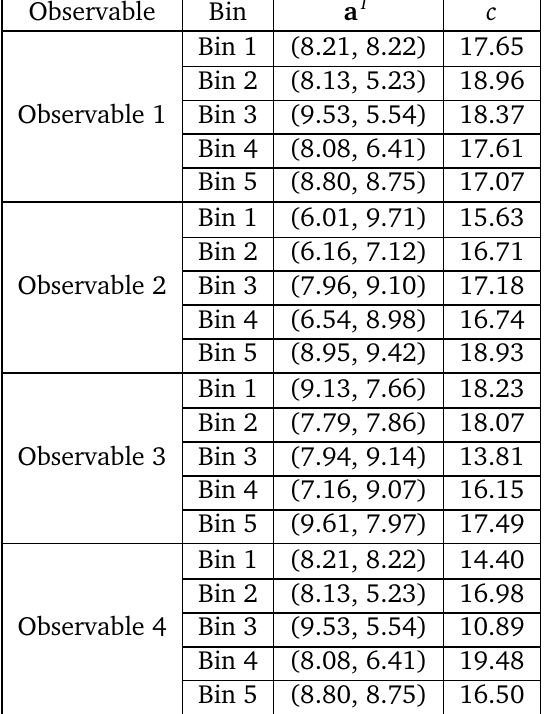
( p ) for each bin b , which is a linear b